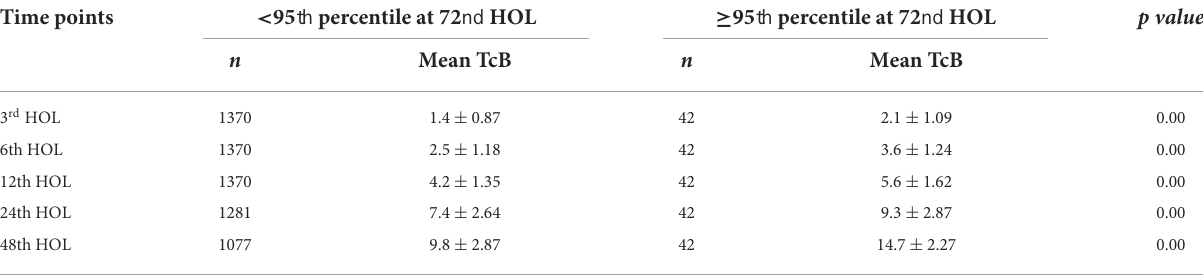
TABLE 1 Comparison of mean bilirubin levels at different time points and subsequent high risk zone status at the 72nd HOL. Time points < 95 th percentile at 72 nd HOL ≥ 95 th percentile at 72 nd HOL n